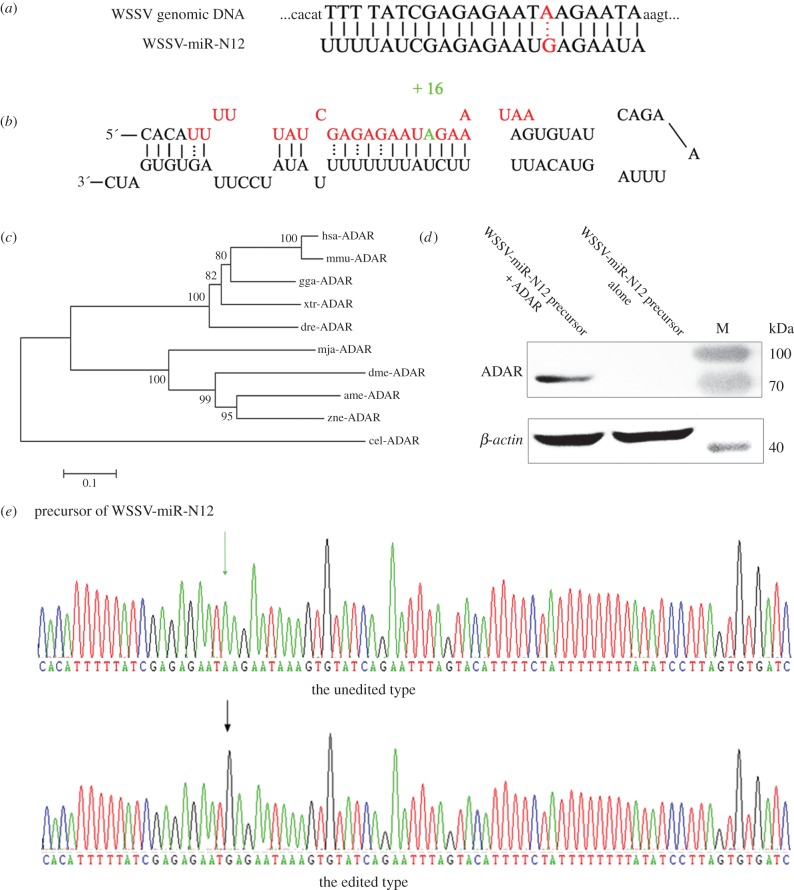
Viral miRNA editing mediated by host adenosine deaminase acting on RNA (ADAR). (a) Comparison of WSSV-miR-N12 mature sequence with the WSSV genomic DNA sequence. The editing site was coloured. (b) The predicted hairpin structure of WSSV-miRNA-N12 precursor using mFold software (http://frontend.bioinfo.rpi.edu/applications/mfold/). Red indicates the mature sequence of WSSV-miRNA-N12. Green indicates the potential A-to-I editing site. (c) Neighbour-joining phylogenetic tree analysis of ADAR proteins of vertebrates and invertebrates. Bootstrap values are shown. The bar represents the distance. hsa, Homo sapiens; mmu, Mus musculus; xtr, Xenopus (Silurana) tropicalis; gga, Gallus gallus; dre, Danio rerio; dme, Drosophila melanogaster; ame, Apis mellifera; cel, Caenorhabditis elegans; zne, Zootermopsis nevadensis. (d) Western blot analysis of the expressed shrimp ADAR protein in insect cells. The plasmid expressing the V5-ADAR fusion protein and the synthetic WSSV-miRNA-N12 precursor were cotransfected into insect cells. The synthetic WSSV-miRNA-N12 precursor alone was included in the transfection as a control. The expression of shrimp ADAR was detected by the V5 antibody. M, protein marker. (e) The involvement of shrimp ADAR in the RNA editing of viral miRNA. The total RNAs were extracted from insect cells transfected with the plasmid expressing the shrimp ADAR protein and/or the synthetic WSSV-miRNA-N12 precursor. Then the precursor of WSSV-miRNA-N12 was cloned and sequenced. The positions of the edited site and the unedited site are indicated with arrows.